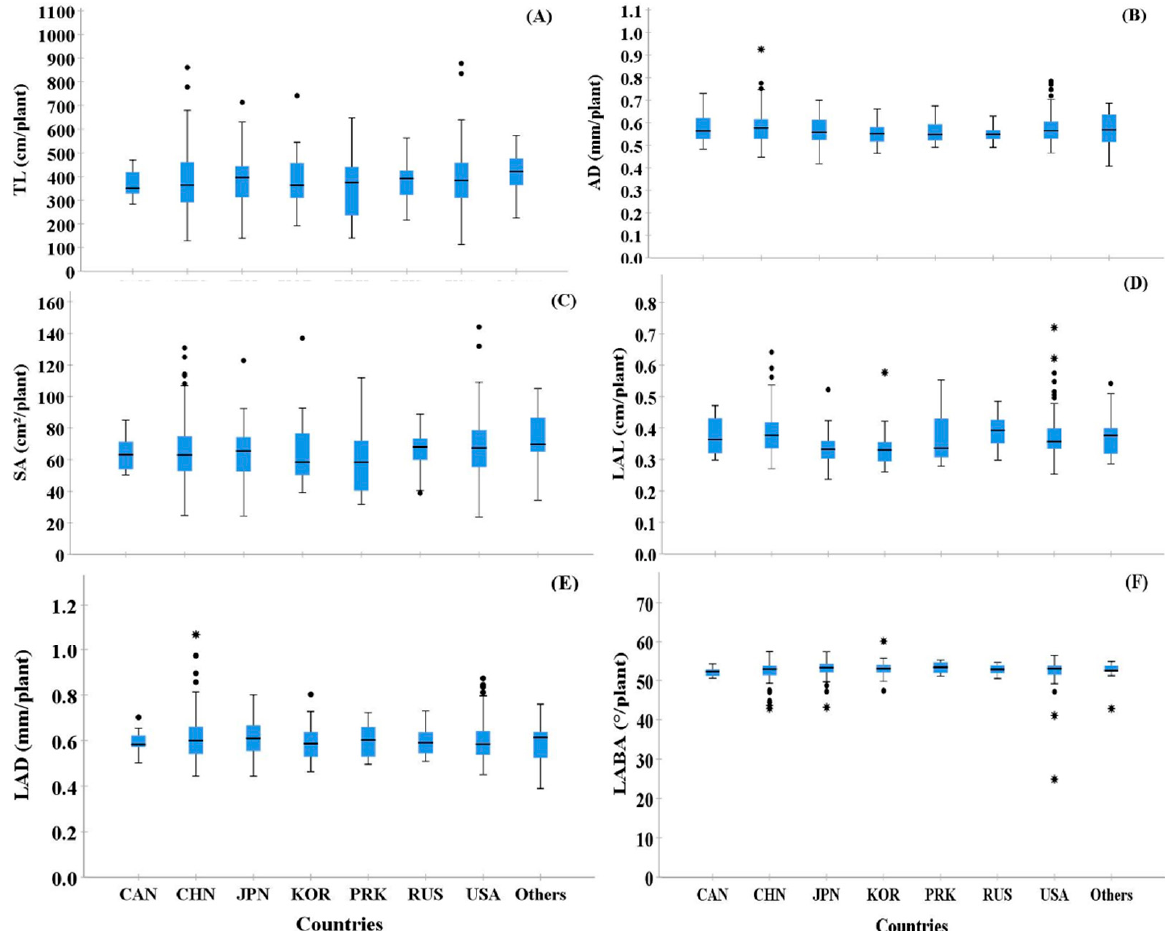
Figure 3. Box plots showing the shape of the distribution, central value, and variability of root traits from the 372 cultivars examined based on the eight-country groups, which were separated by collection regions. In the figure, ◦ and * indicate high and extremely high values in the observations, respectively, and are called outliers in the data. In the figure, A – E indicate following: TL ( A ), AD ( B ), SA ( C ), LAL ( D ), LAD ( E ), and LABA ( F